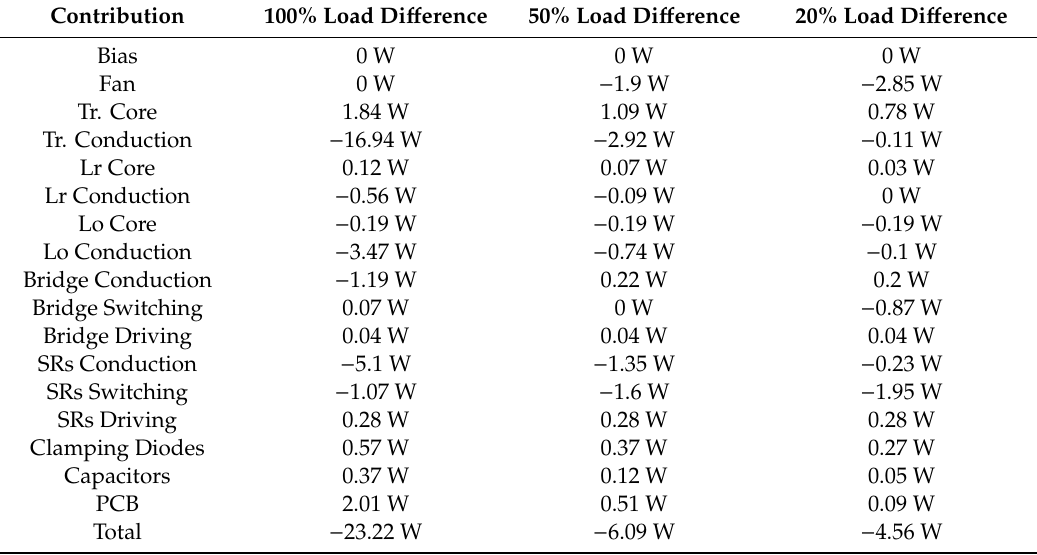
Table 13. Summary of di ff erence of losses between the optimized and the reference